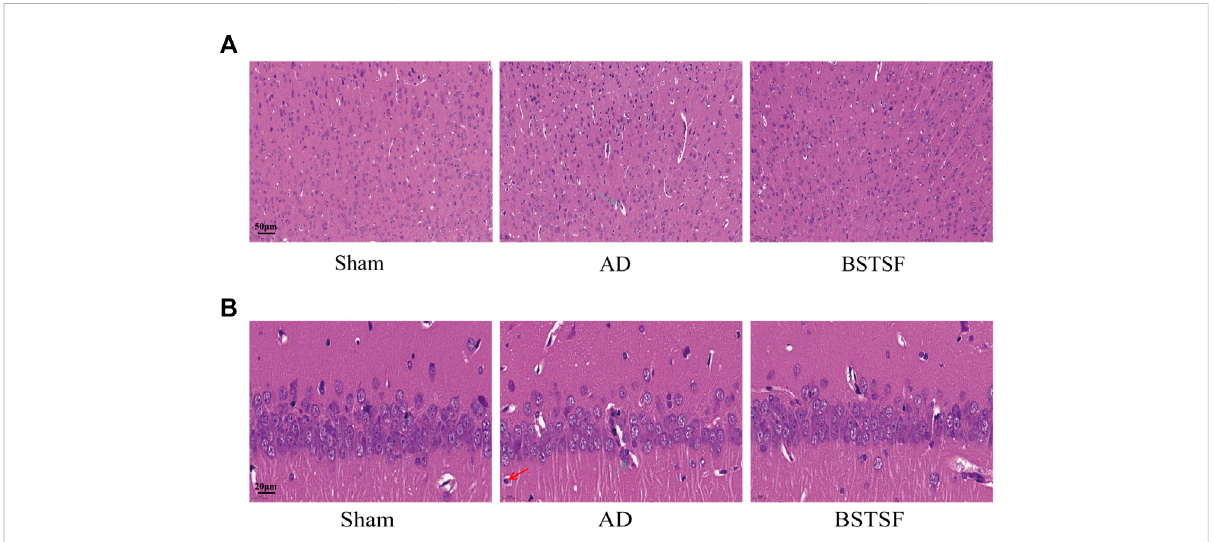
FIGURE 2 Representative images of HE staining in the cerebral cortex (A) and hippocampus (B) . The magni fi cation: (A) 20×, (B) 63×. The green arrows indicate sites of structural disorder and hyperemia, the red arrows indicate sites of the with pale and oval nucleus and more